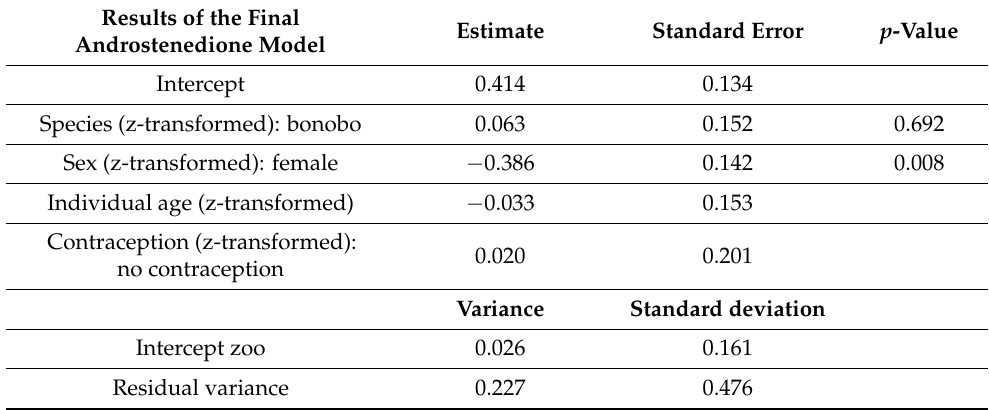
Table 4. Results of the final androstenedione model. The model contained the main effects of species (bonobos vs chimpanzees), sex (female vs male), the age of the subject at the time of sample collection, whether an individual was on contraceptives, and a random intercept for zoo. Estimates, standard errors, and p -values for individual variables are shown. Reference categories are indicated for categorical